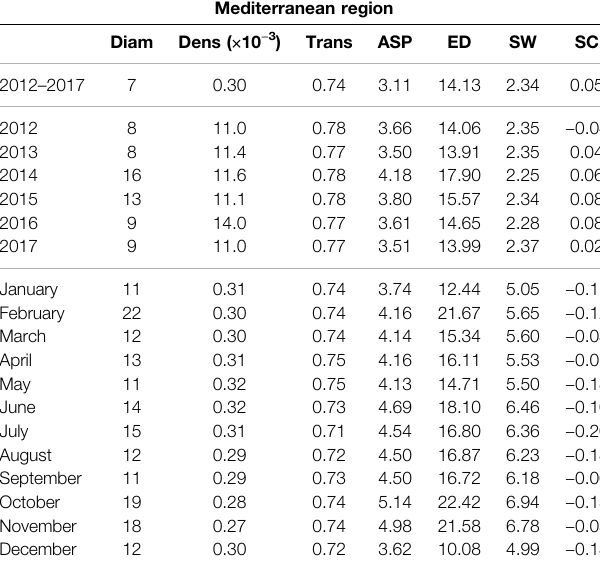
TABLE 1 | Network indices [Diameter (Diam), density (Dens), transitivity (Trans), average shortest path (ASP), effective distance (ED), small worldness (SW), strength correlation (SC)] calculated from the networks covering the Mediterranean region and estimated in three temporal contexts: the entire period 2012 – 2017,yearly time periods from 2012to2017and monthlytime periods.